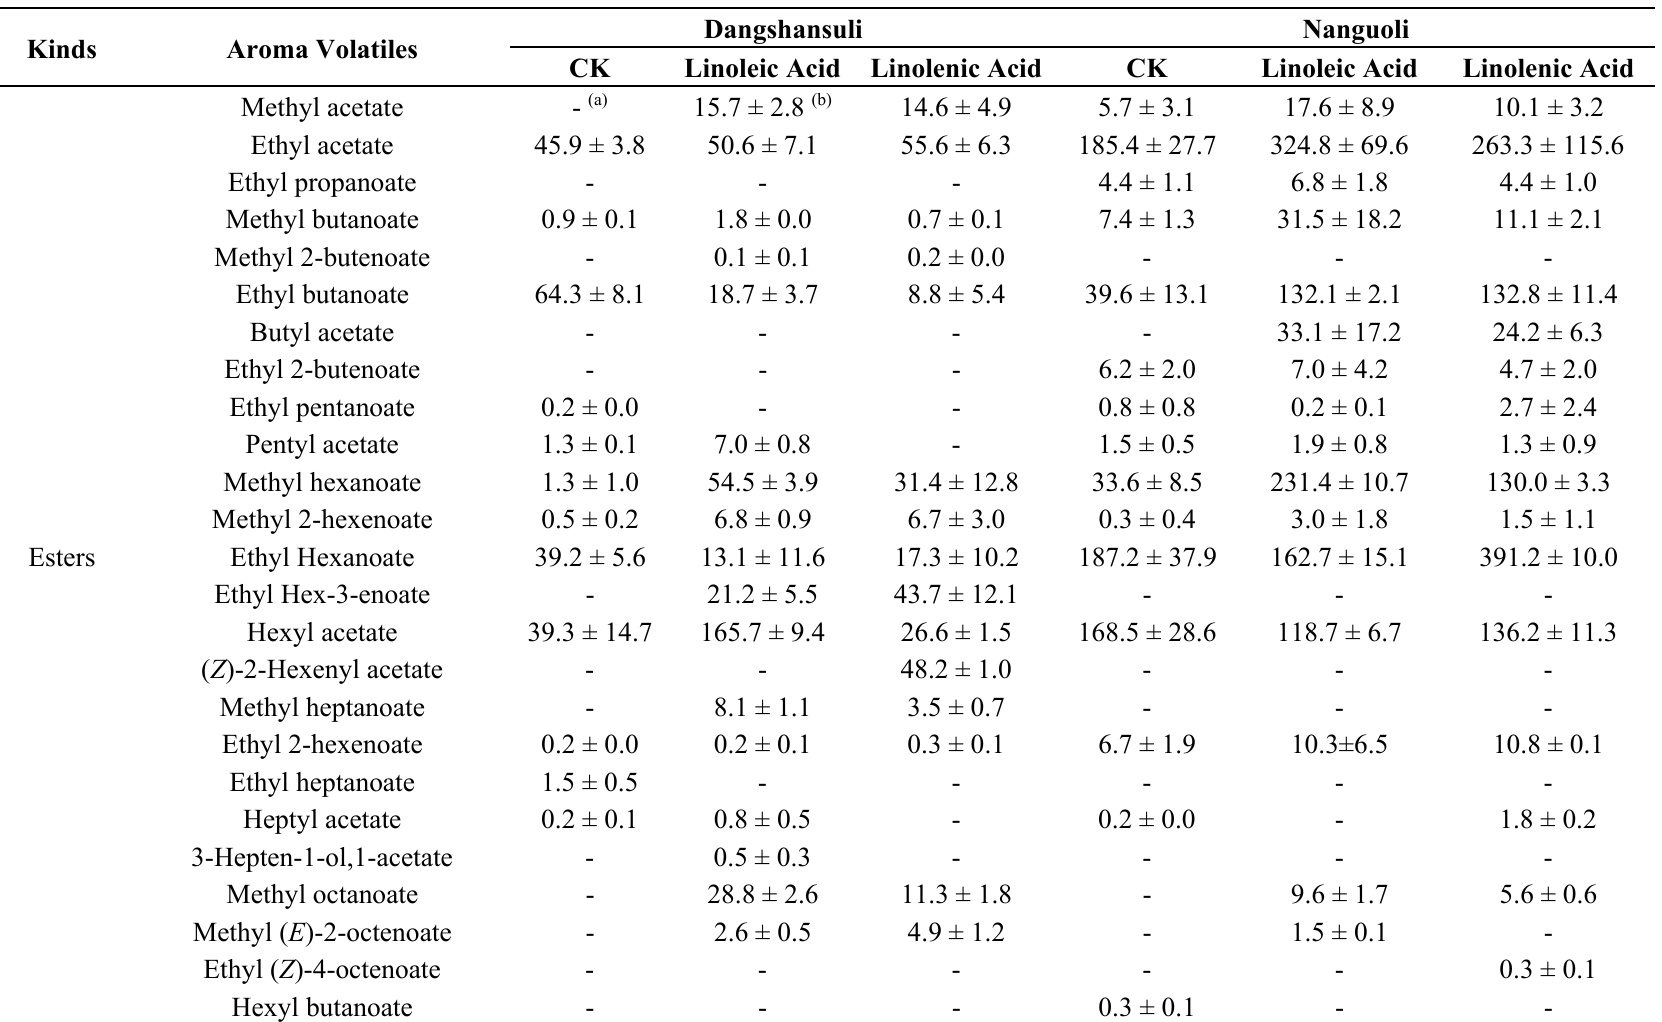
Table 1. Contents (ng·g − 1 ·FW) of aroma volatiles derived from fatty acid metabolism for pear fruits feeding on linoleic acid and linolenic acid; (a) -, not detected; (b) Values represented means ± SD of three replicates; (c) Capitals denoted significant difference in a line for one cultivar at the level of 0.01. Lowercase letters denoted significant differences in a line for one cultivar at the level of 0.05, according to Duncan’s